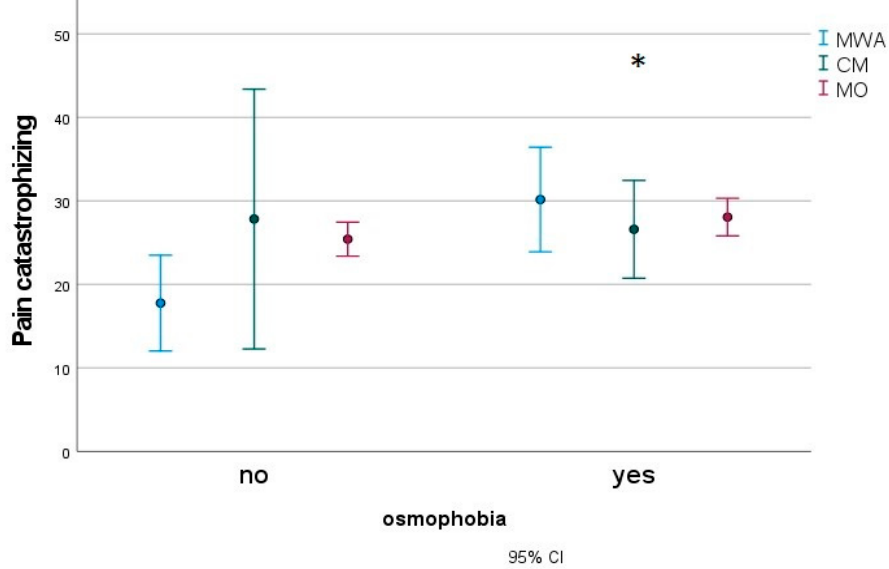
Figure 6. Mean and 95% C.I. of Pain Catastrophizing scores in osmophobic and non-osmophobic migraine children. MWA: migraine with aura; MO: migraine without aura; CM: chronic migraine. Results for osmophobia as a factor * F 4.34, p = 0.038.